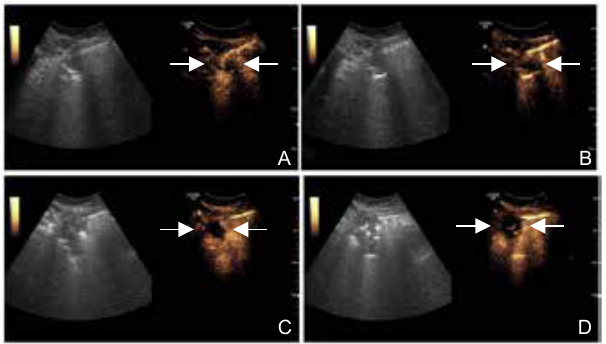
Figure 4 The US apparatus (LOGIQ E9, GE Healthcare, Milwaukee, WI, USA) coupled with magnetic field generator. Arrow ① Two electromagnetic position sensors. Arrow ② The magnetic transmitter. Arrow ③ The position tracking module.